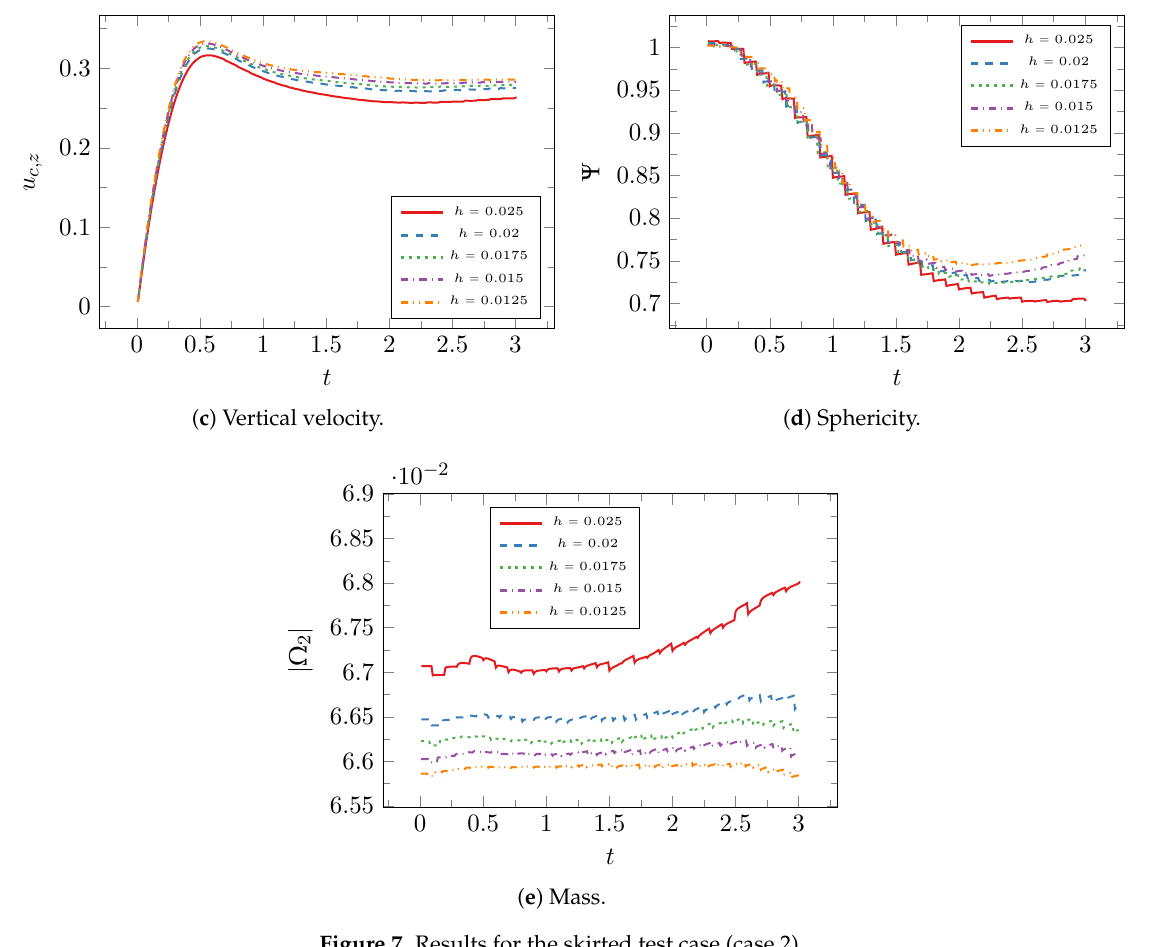
Figure 7. Results for the skirted test case (case 2).